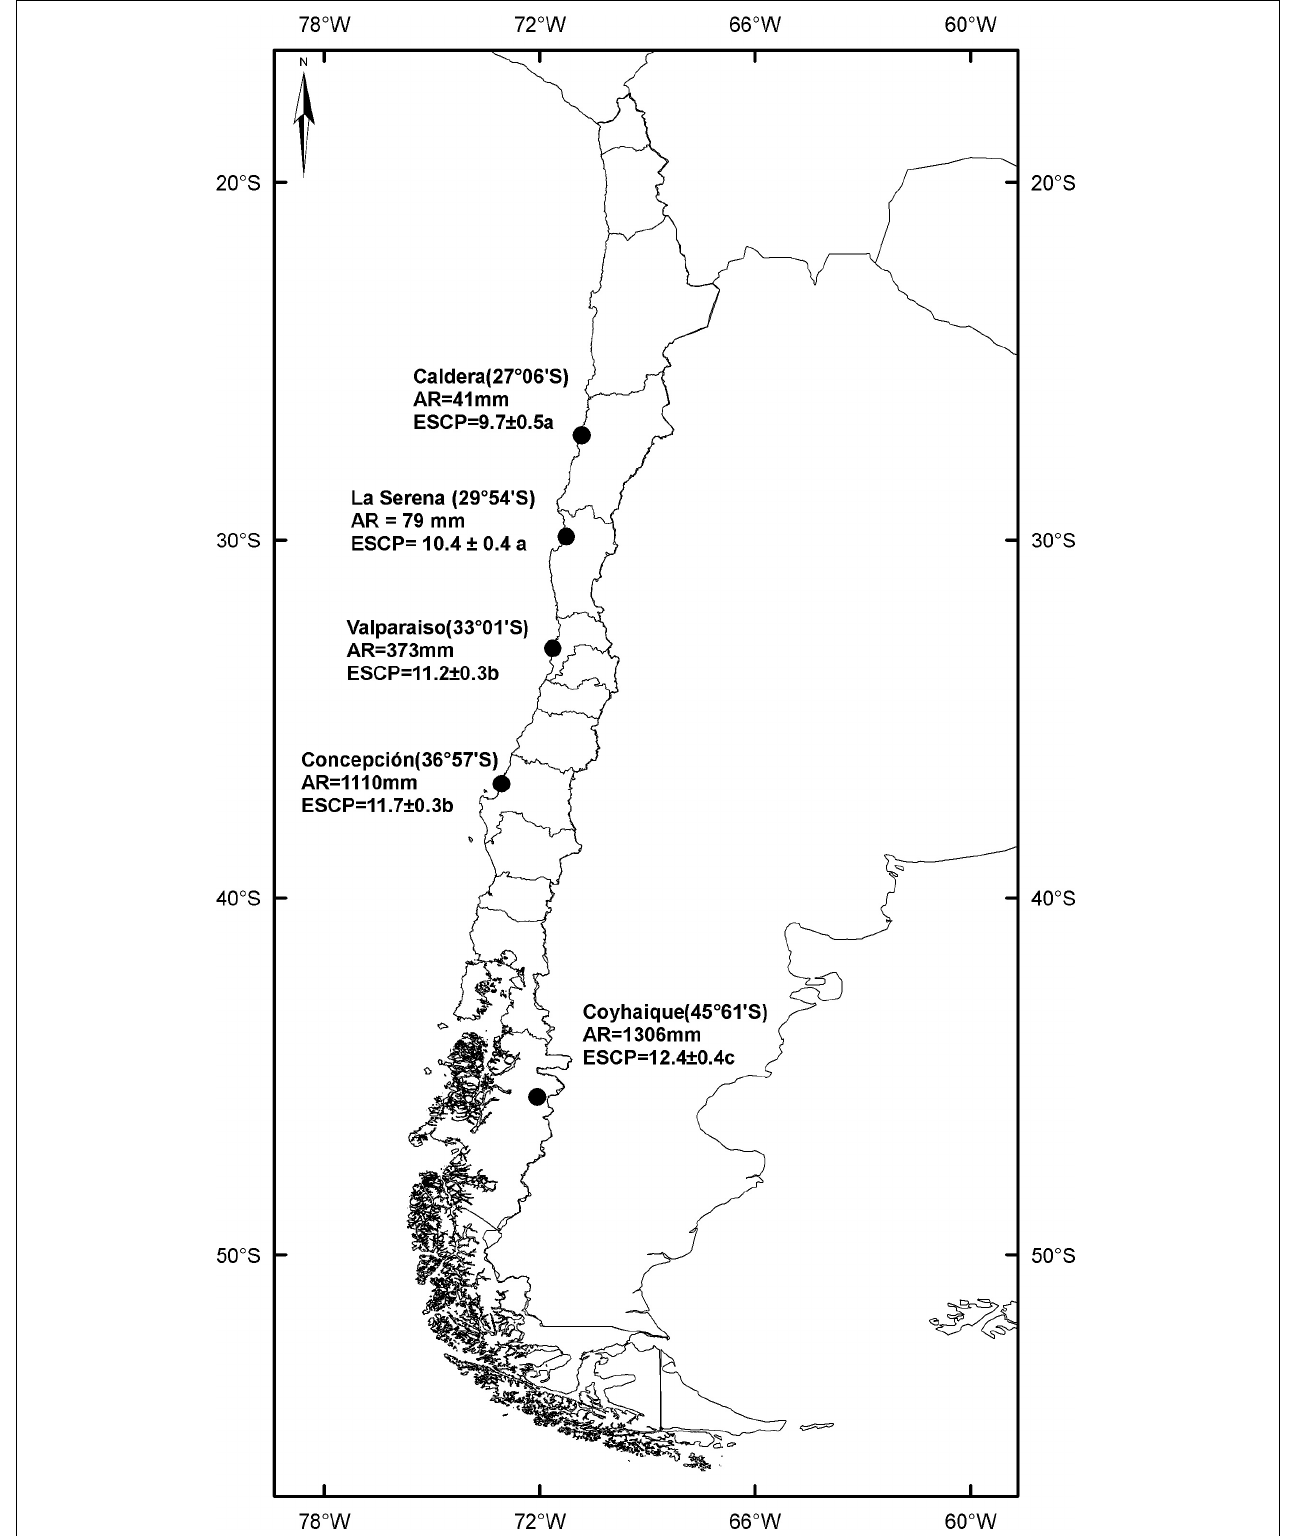
FIGURE 1 | Map showing the five sampled localities along the latitudinal gradient. Annual rainfall (AR) and endosperm to seed coat proportion (ESCP) are given for each locality. Significant differences between ESCP values are denoted with different letters ( a posteriori Tukey test α = 0.05).